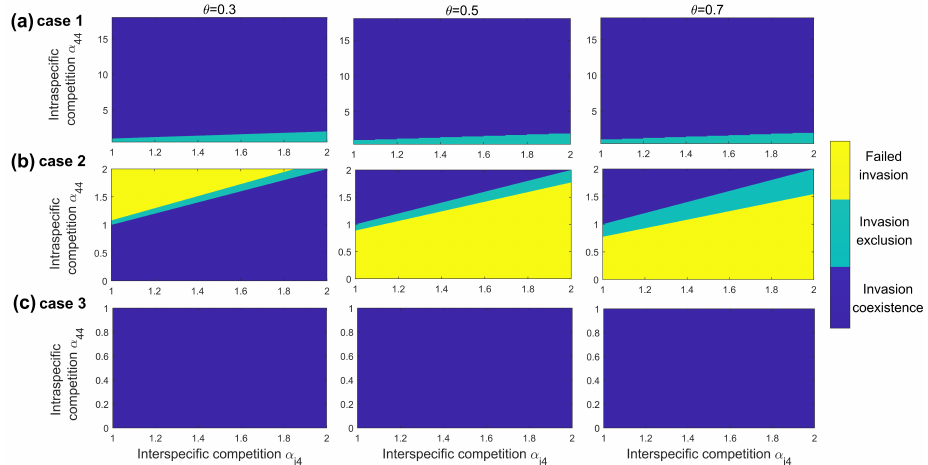
Figure 6. Parameter ranges for different invasive consequences (assuming alien species compete with all three native species). Different figure rows represent native communities which supported by ( a ) strong niche departure (case 1), ( b ) the combination of niche differentiation and intransitive competition (case 2), and ( c ) intransitive competition (case 3). Each columns exhibit three levels of competitive symmetry 1 − θ = 0.7, 0.5, 0.3. X axis represents the interspecific competition intensity between alien species and native species i, α i 4 i = 1,2, 3. Here we assume α 14 = α 24 = α 34 . Y axis is intraspecific competition intensity of alien species α 44 . The parameter space is divided into several parts. Blue color area represents successful establishment of invader. Green color region suggests the conditions when alien species pose destructive effect and cause native extinctions; yellow color area identify the invasion failure. Other parameters are set the same with Figure